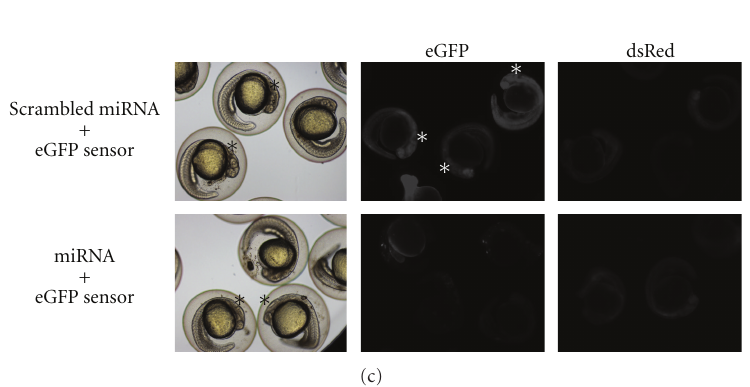
Figure 1: miRNA constructs and their e ff ects in zebrafish embryos. (a) Schematic of the miRNA and the eGFP sensor vectors showing the miRNA target sites as well as the qRT-PCR primer locations. The miRNA vector contains a CMV promoter for ubiquitous expression in all tissues, and a DsRed Express reporter gene and the pre-miRNAs. The pre-miRNAs can be single (only one miRNA) or chained (containing more than one miRNA under the same promoter). The eGPF sensor miRNA also contains a CMV promoter, an eGFP reporter gene, and the mature miRNA target at the 3 (cid:2) UTR of the eGFP gene. The miRNA target sites for zerg-2 are located in exons 9 (miRNA 1), 14 no. 1 (miRNA 2), 14 no. 2 (miRNA 3), and 3 (cid:2) UTR (miRNA 4). The miRNA targets for zerg-3 are located in exon 8 (miRNA 1), exon 15 (miRNA 2), and two targets located on the 3 (cid:2) UTR. (b) The injection of eGFP sensor mRNA alone produces embryos that exhibit green fluorescence only, and embryos injected with both eGFP sensor and miRNA mRNA exhibit both green and red fluorescence. (c) An example of embryos injected with either miRNA with eGFP sensor or scrambled miRNA (negative control) with eGFP sensor. The ∗ indicates the presence of the midbrain hindbrain